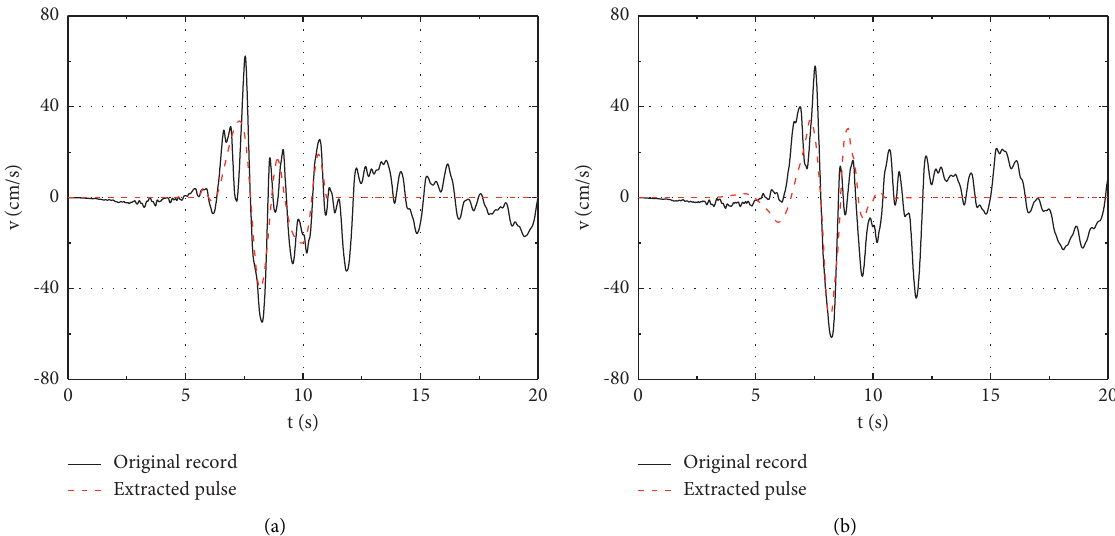
Figure 16: No. 776 ground motion. (a) The extracted pulse based on HHT. (b) The extracted pulse based on